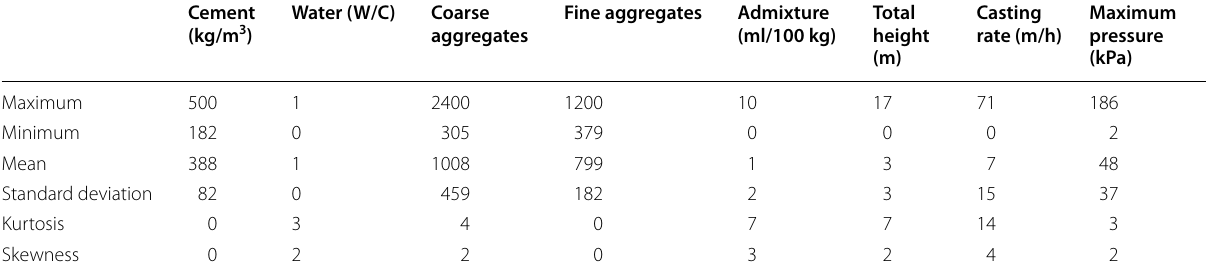
Table 1 Descriptive statistics of the input and output variables.